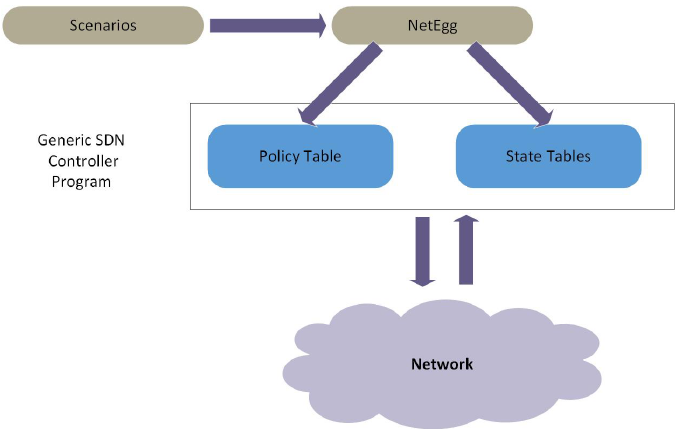
Figure 4. NetEgg Design layout using Generic SDN